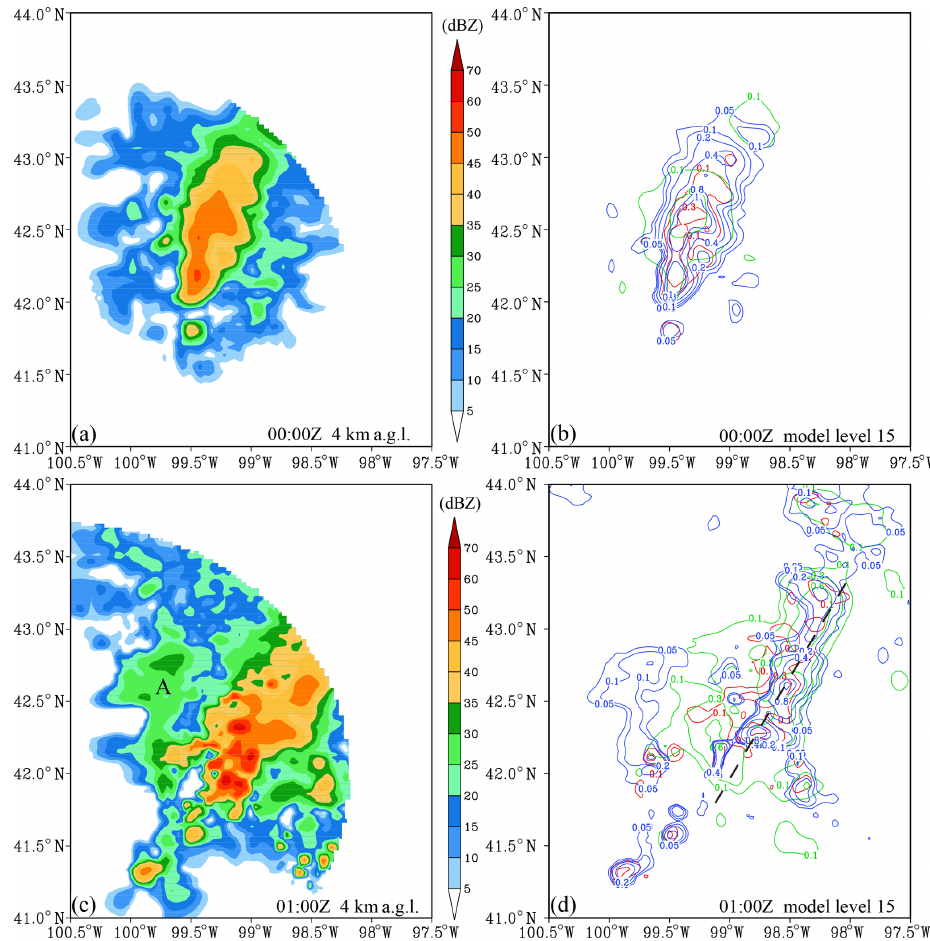
Figure 12. (a, c) The analysis reflectivity at 4kma.g.l. and (b, d) the analyses of q r (red), q s (green), and q g (blue) at model level 15 at 00:00 and 01:00Z for the experiments without hydrometeor